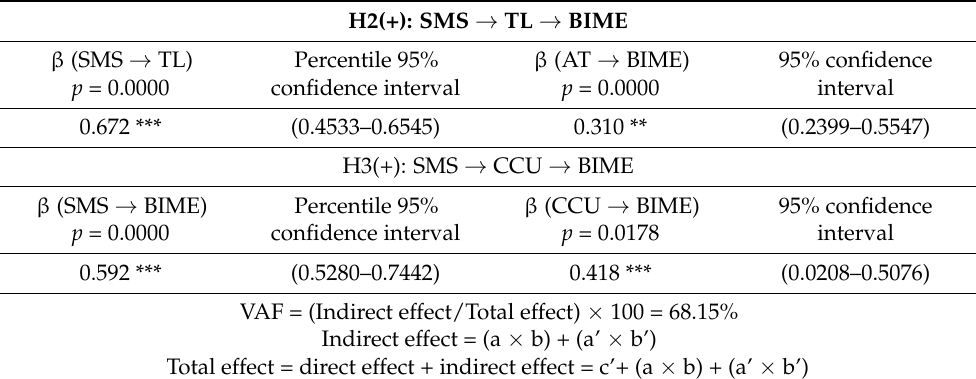
Table 5. Hypothesis testing and mediation